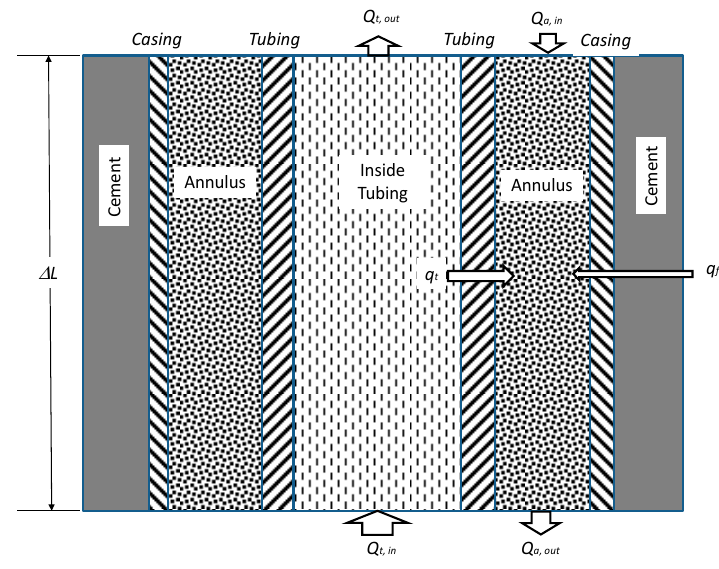
Figure 1. Sketch illustrating heat transfer in a wellbore section.